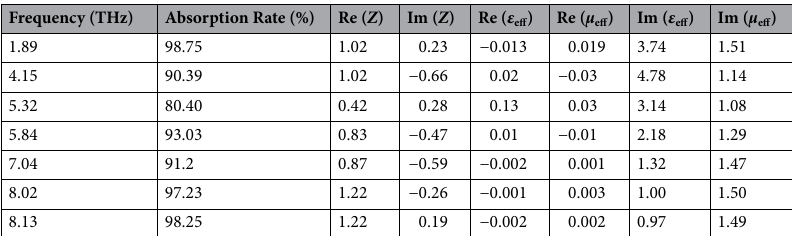
Table 3. Comparison of absorption rate, normalized impedance and EM parameters.